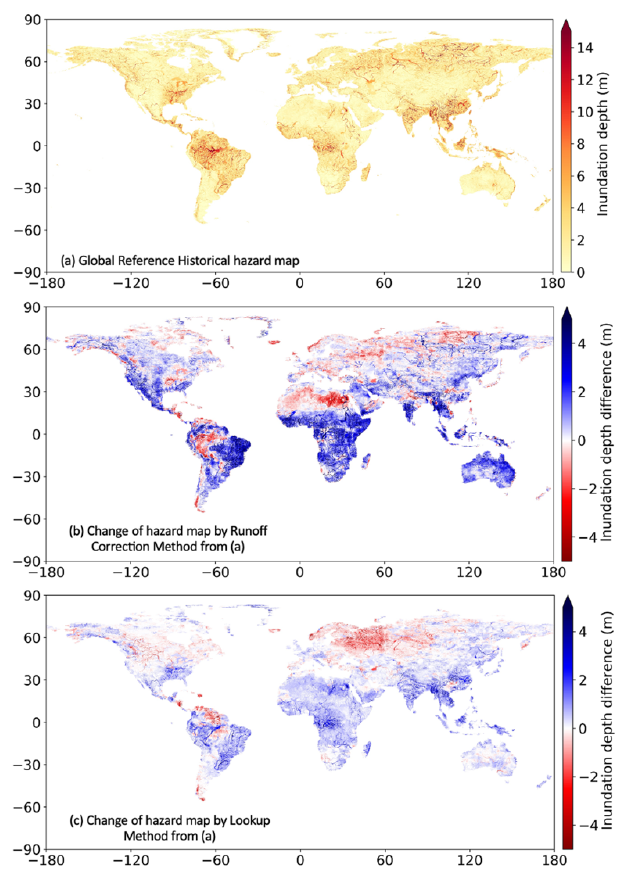
Figure 2. 100-year RP inundation-depth distributions for (a) a global reference historical-hazard map, (b) future-hazard changes obtained using the runoff-correction method (using IPSL-CM6A- LR) relative to (a) and (c) future-hazard changes obtained with the lookup method (using IPSL-CM6A-LR) relative to panel (a)